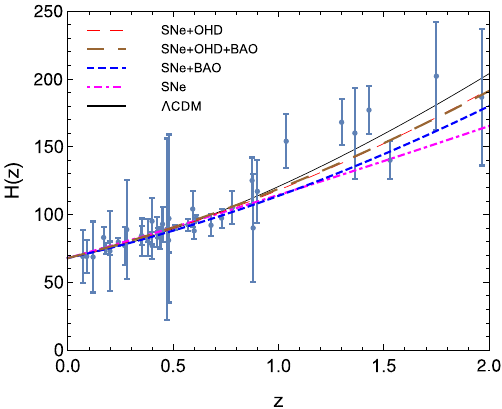
Fig. 9 Variation of the Hubble function as a function of the redshift z for the best-fit values of the model. The observational 43 H ( z ) points are shown with error bars (grey colour). The variation of the Hubble function in the standard Λ CDM model is also represented as the solid curve